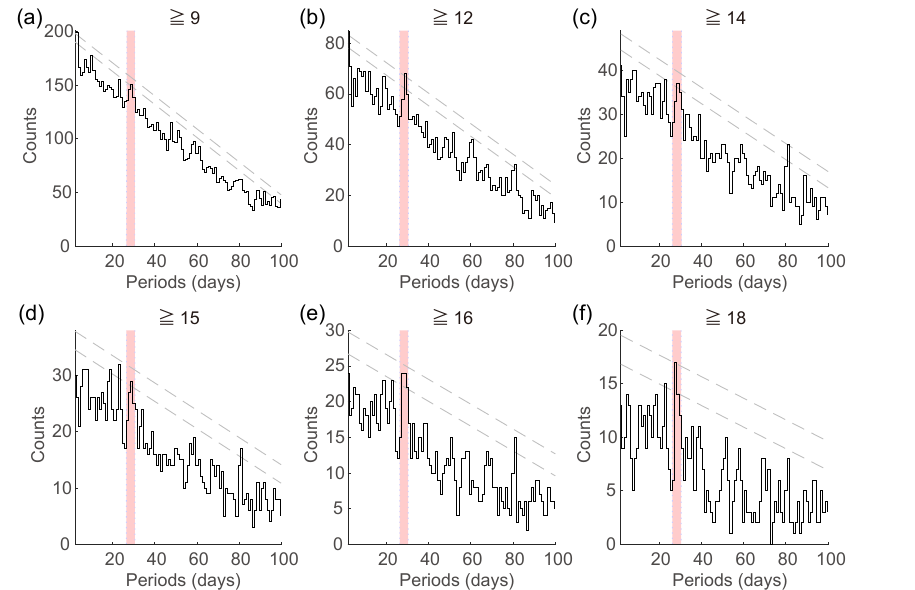
Figure 2. Histogram of number of days between every combination of two lightning days covering more than (a) 9, (b) 12, (c) 14, (d) 15, (e) 16, and (f) 18 prefectures. Gray dashed lines indicate significance levels of 2 and 3 standard deviations. Red-shaded bars indicate the 27–30-day period.